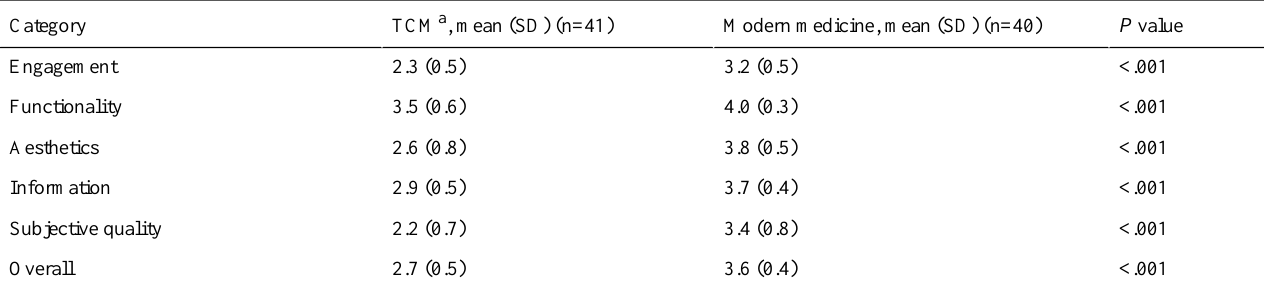
Table 3. Comparison of TCM and modern medicine apps’results for the Mobile App Rating Scale